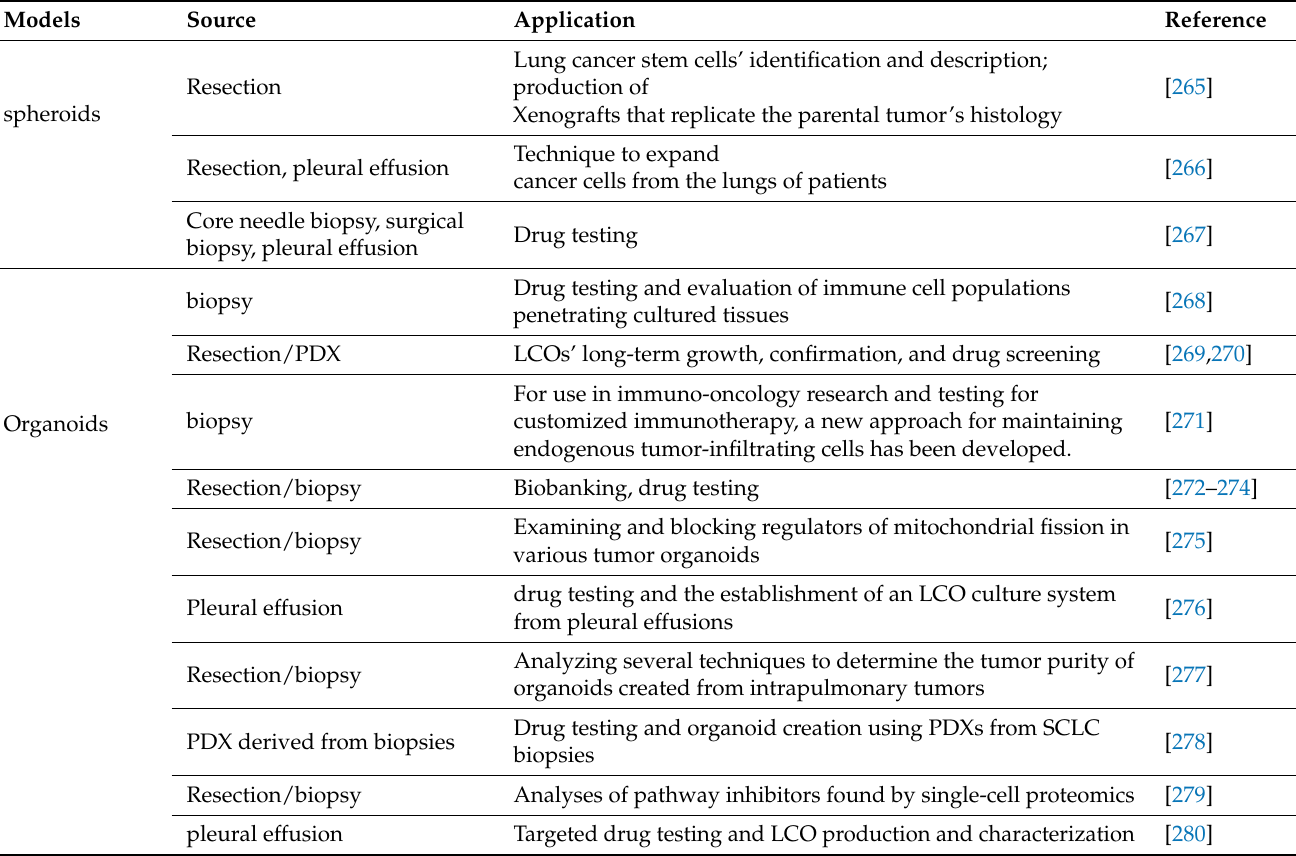
Table 4. The main studies conducted in the field of lung cancer using spheroids and organoids models.